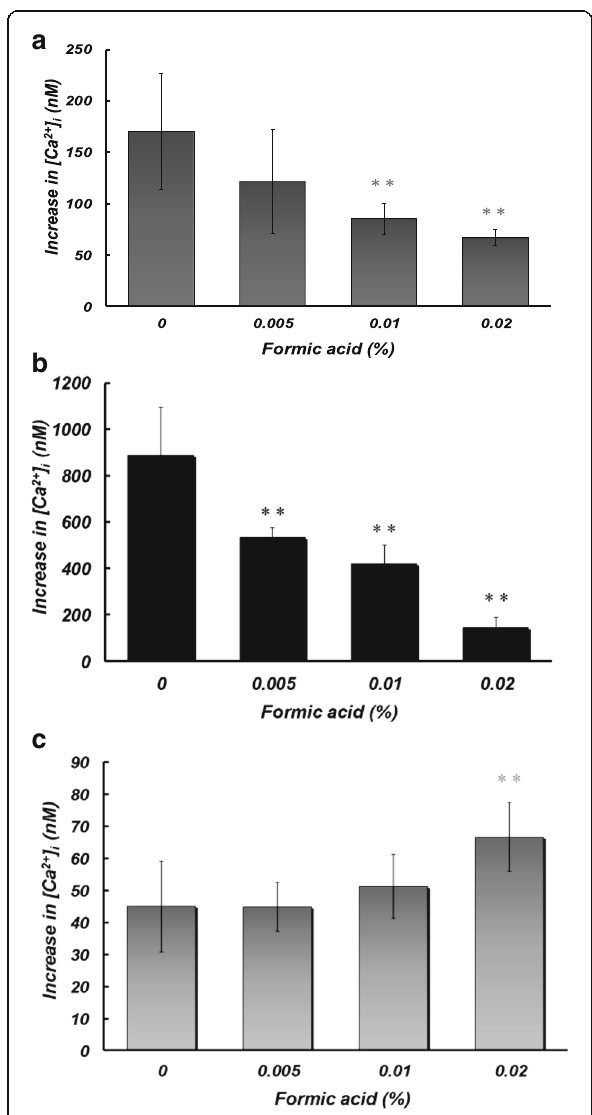
Fig. 5 Effects of pretreatment with different concentrations (0, 0.005, 0.01, and 0.02%) of formic acid on Ca 2+ entry induced by extracellular addition of CaCl 2 (0.5 mM) in the presence of thrombin (0.025 U/ml) ( a ), thapsigargin (1 μ M) ( b ), or OAG (100 μ M) ( c ). Asterisks denote significant differences (** p < 0.01) compared with the control. N = 8 –